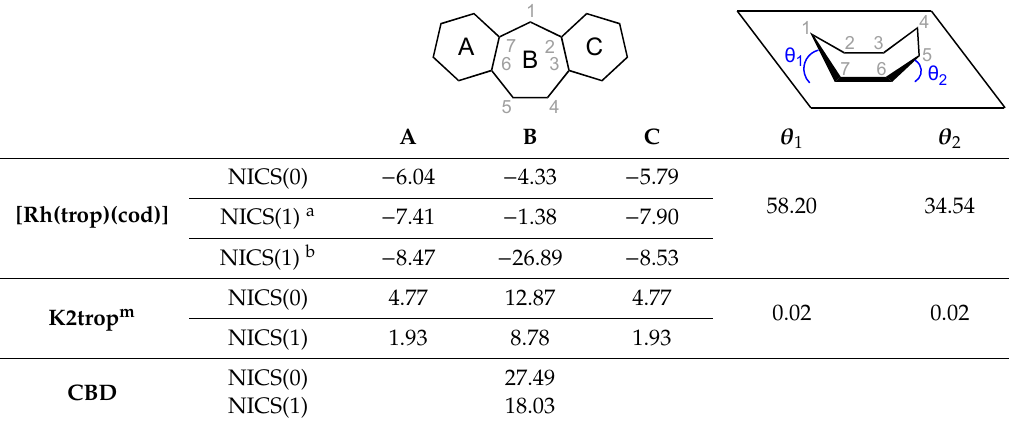
Molecules 2020 , 25 , x FOR PEER REVIEW Table 6. Calculated isotropic NICS(0) and NICS(1) values (ppm) for dianionic dbcot compounds.